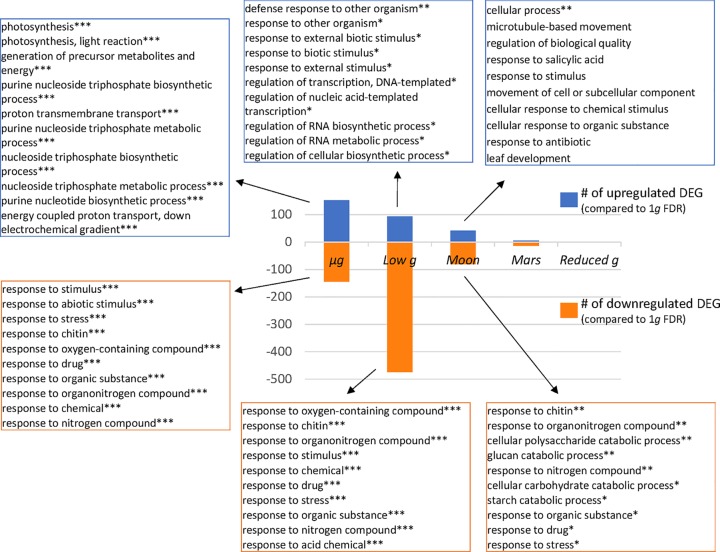
Biological processes affected by reduced gravity (Panther Enrichment in biological process GO). Total number of up-regulated and down-regulated DEG (p < 0.05) are shown for the five reduced gravity conditions vs. 1g control. The ten most significant gene ontology (Panther biological process GO Enrichment) categories for the three upregulated and the three downregulated DEGs are shown for the microgravity, low gravity (circa 0.1g) and Moon gravity (0.18g) vs. 1g (*** FDR q < 0.001, **FDR q < 0.01, *FDR q > 0.05).